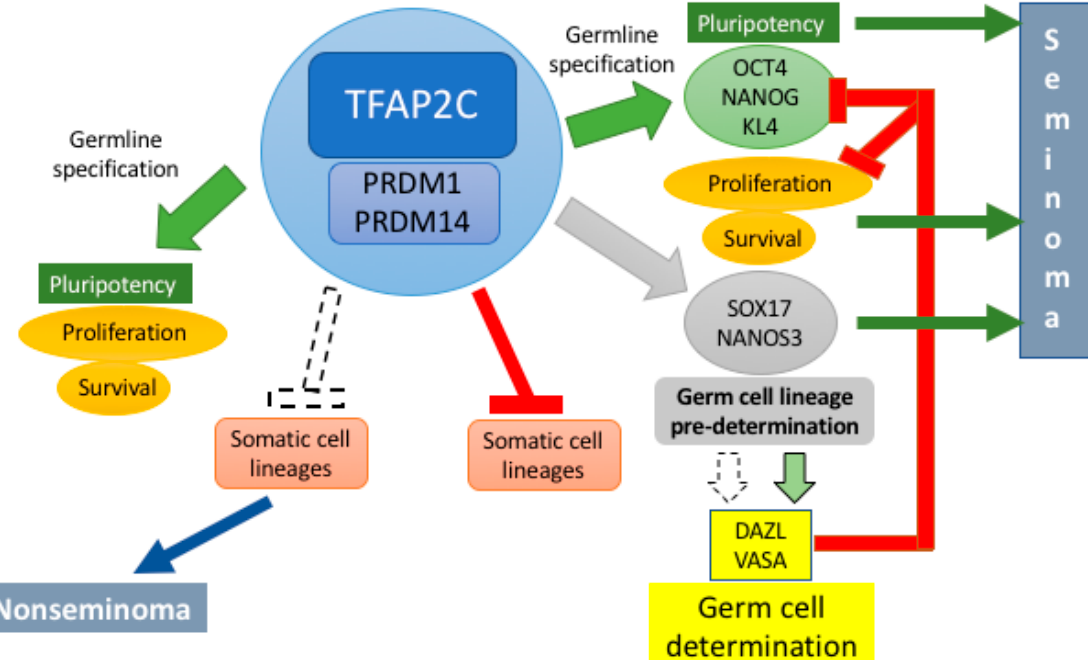
Figure 3. Schematic and simplistic hypothesis of the transcription factor core circuits crucially involved in the specification and determination of the human germline and of the possible origin of the extragonadal germ cell tumors discussed in the present review. Briefly, the expression of transcription factors TFAP2C, PRDM1, and PRDM14, necessary for the germline specification, control the pluripotency transcription factors (OCT4, NANOG, KL4) and associated proliferation/survival circuits. At the same time TFAP2C, PRDM1, and PRDM14 inhibit somatic cell lineages; subsequently, SOX17 and NANOS3 direct the PGC precursors to a pre-determined germ cell stage. Within the gonads, DAZL and VASA complete PGC determination as germ cells and repress pluripotency and proliferation while TFAP2C, PRDM1, and PRDM14 are progressively downregulated. Seminoma could arise (green arrows) when PGC determination is not completed (dotted arrow), the survival maintained and proliferation prolonged or, under certain condition, re-established (green arrows); conversely, nonseminoma could arise (blue arrow) if PGCs remain only specified, the inhibitory action of TFAP2C, PRDM1, and PRDM14 on somatic cell lineage differentiation not maintained, the survival maintained and proliferation prolonged or, under certain condition, re-established.